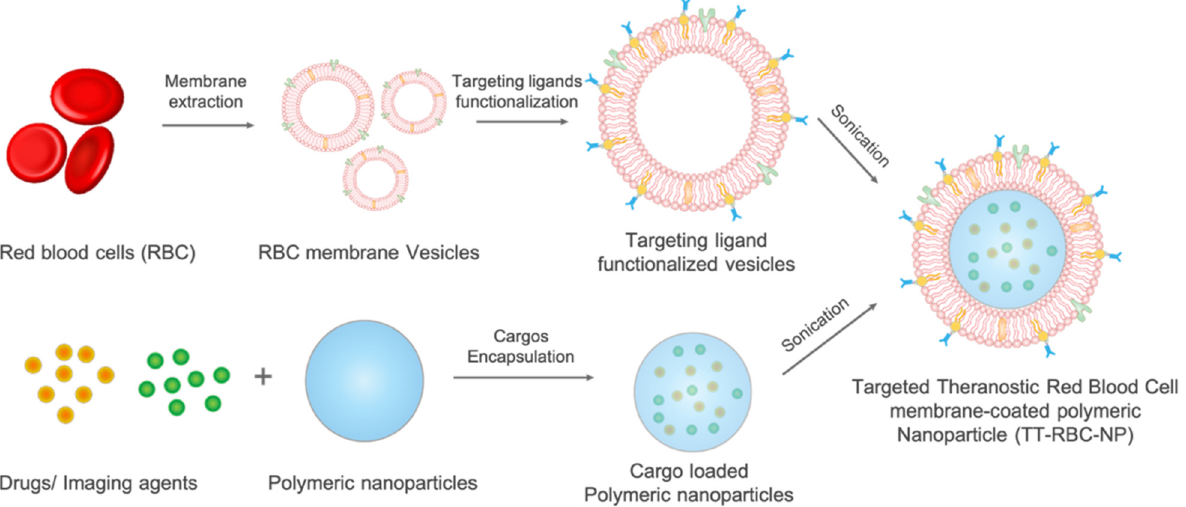
Figure 1. Schematic illustration of the targeted theranostic red blood cell membrane-coated nanoparticles (TT-RBC-NPs). Red blood cell membrane is extracted by hypotonic treatment, sonication, and extrusion. Targeting ligands are functionalized by lipid insertion into red blood cells membrane vesicles. The targeting ligand functionalized vesicles are coated on cargo-loaded polymeric cores to form TT-RBC-NPs.